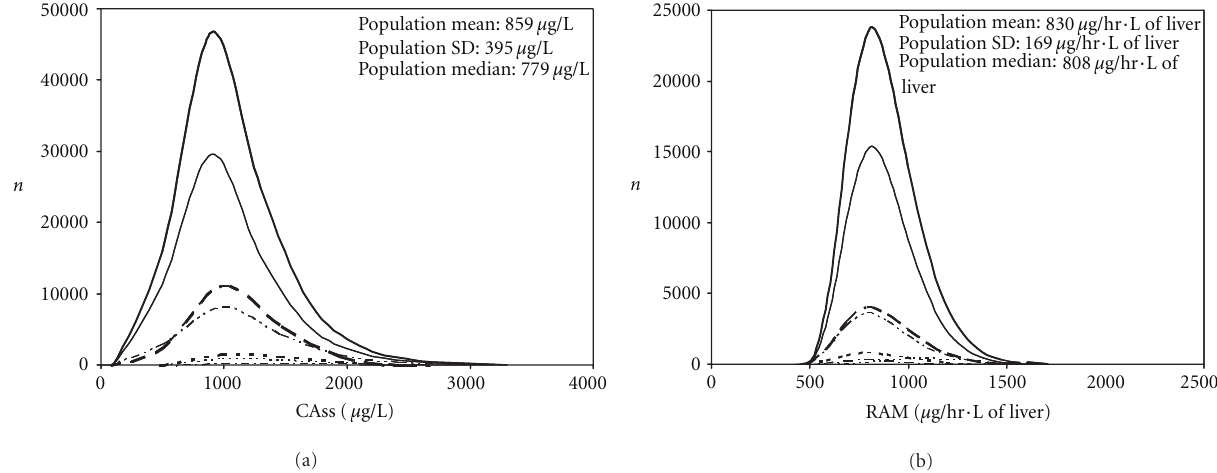
Figure 2: Distributions of individual values obtained for CAss (a) and RAM (b) in each subpopulation within the whole Canadian population for constant inhalation exposure to 1,4-dioxane. From top to bottom, the distributions are shown for the entire Canadian population (thick — ), adults (—), children and adolescents ( —– ), elderly (– · – · –), toddlers ( ––- ), pregnant women (-------), infants (- · - · - · -), and neonates